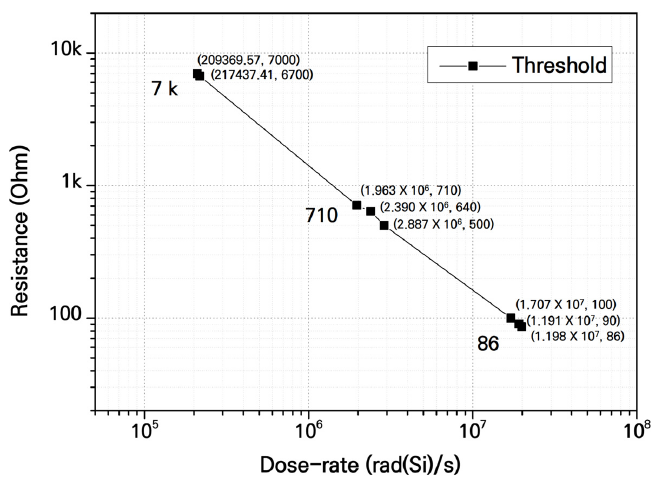
Figure 16. Dose detection range of proposed radiation detection circuit according to the R th resistance. The resistance (R th ) was set to 7 k Ω , which corresponds to the detection range 2.0 × 10 7 rad(si)/s (error rate 10%) of the proposed detection circuit, and the beam was then